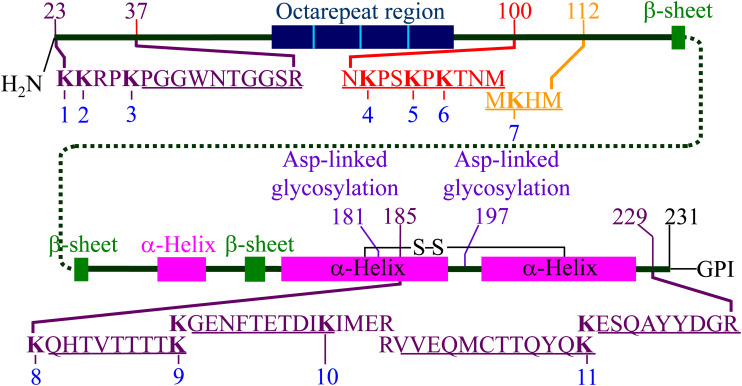
Representation of hamster PrPC including the locations of secondary structures and the position of the 11 lysine residues. The locations of the five tryptic peptides (PGGWNTGGSR, QHTVTTTTK, GENFTETDIK, VVEQMCTTQYQK, and ESQAYYDGR) are indicated. The locations of the chymotryptic peptide (NKPSKPKTNM) and the 3F4 mAb epitope (MKHM) are also indicated. Adapted from Silva et al. (2016). The locations of the secondary structure motifs are based on the NMR structure (1B10 in PDB) (James et al., 1997).